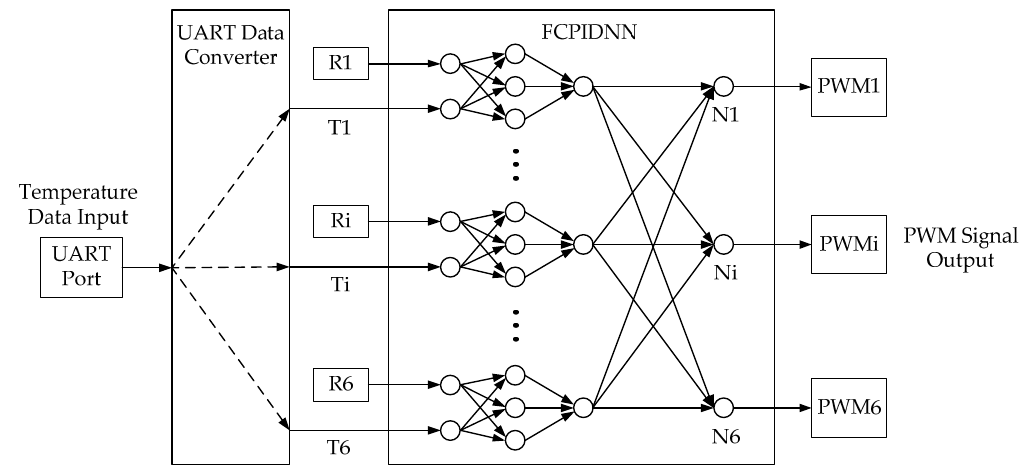
Figure 5. Structure of the FCPIDNN temperature controller for the instrument. PWM: pulse width modulation. UART: universal asynchronous receiver and transmitter.